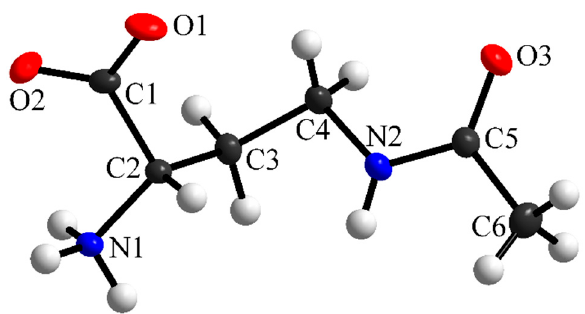
Figure 3. The γ -NADA molecule, obtained from a structure determination at 100 K. Atoms are drawn with anisotropic displacement ellipsoids of the non-hydrogen atoms as well as isotropic ones of the hydrogen atoms at the 80% probability level. Table 2. Bond lengths for γ -NADA at 100 K, distances in